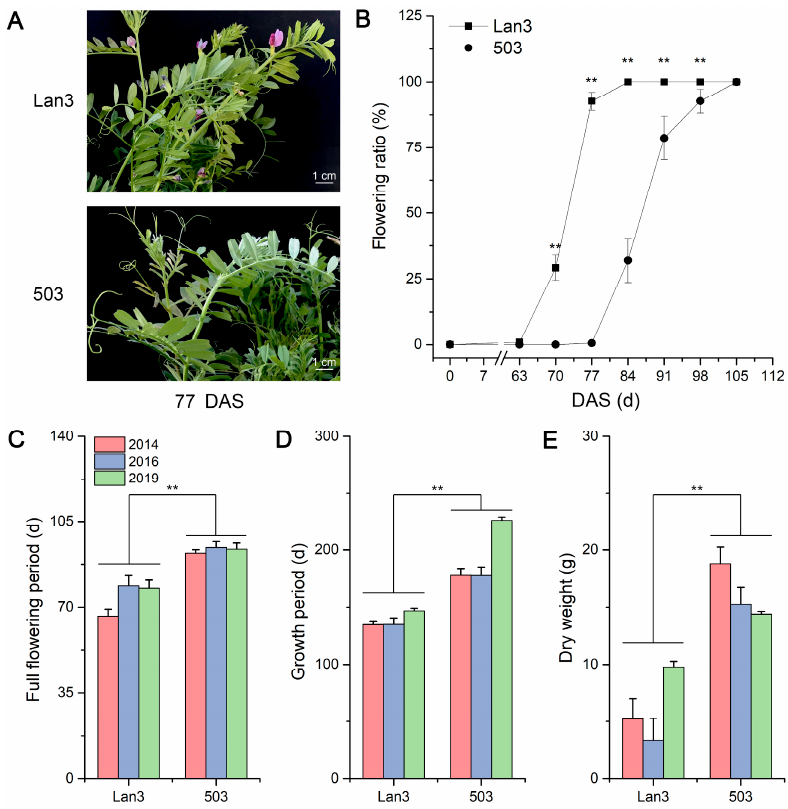
Figure 1. Agronomic characteristics of two V. sativa accessions. ( A ) The phenotypes of two V. sativa accessions 77 DAS. ( B ) Flowering ratio of two V. sativa accessions during the whole growth period. ( C ) Full flowering periods of two V. sativa accessions from three years of field trials. ( D ) Growth periods of two V. sativa accessions from three years of field trials. ( E ) Dry weights of two V. sativa accessions from three years of field trials. Asterisks above the bars indicate significant differences at the 0.01 level according to Duncan’s multiple range test. Scale bar = 1 cm.